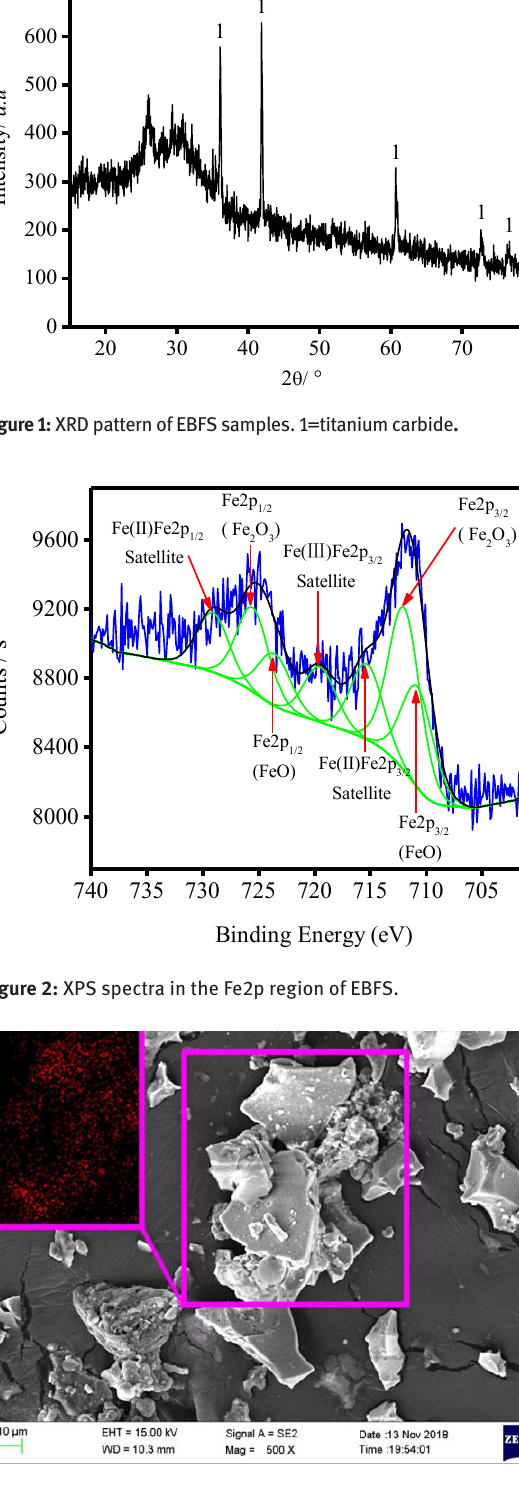
Figure 3. SEM-EDS images of EBFS